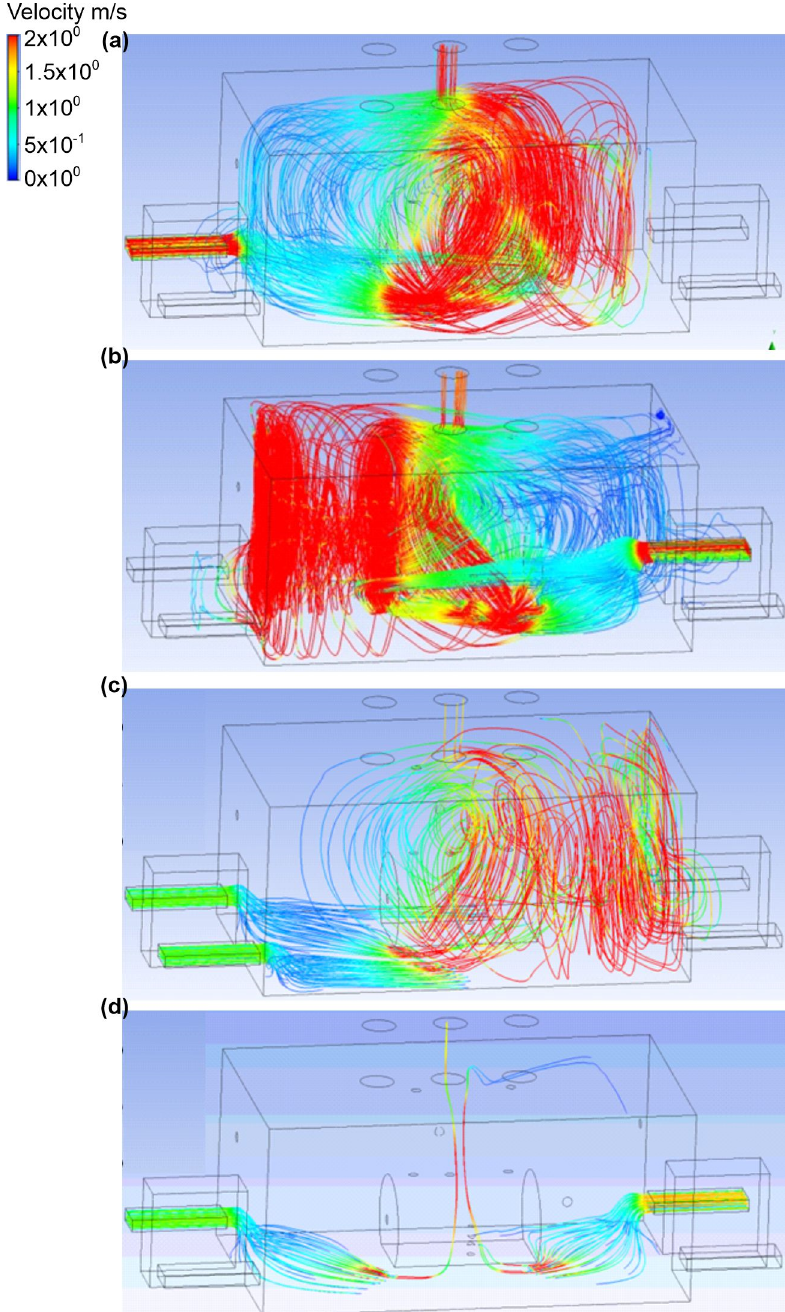
Figure 9. Velocity distribution in the engine room for: ( a ) scenario A, ( b ) scenario B, ( c ) scenario C, and ( d ) scenario D.